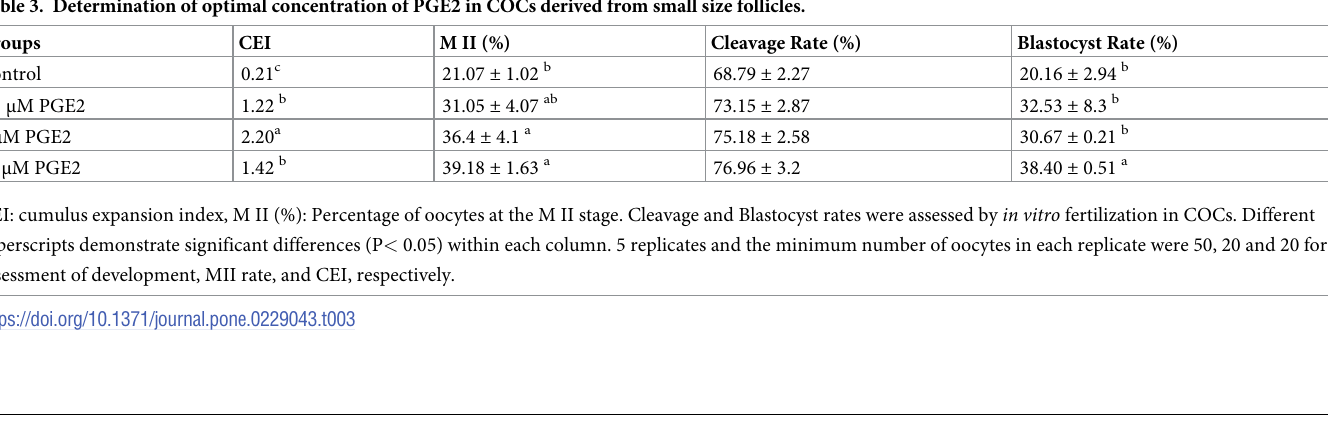
Table 3. Determination of optimal concentration of PGE2 in COCs derived from small size follicles. Groups